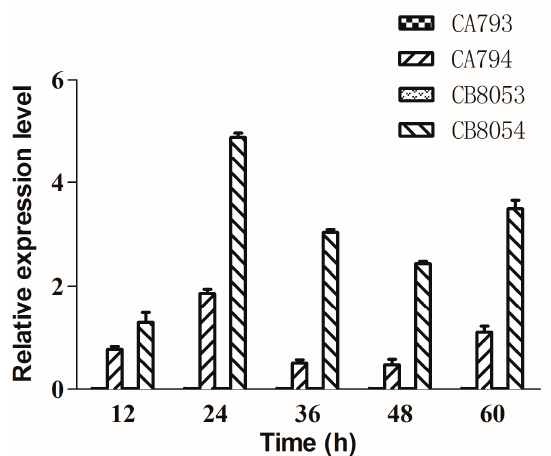
Figure 1. The expression of StSUT1 analyzed by quantitative real time polymerase chain reaction. Cells were collected at 12, 24, 36, 48, and 60 h. Three independent biological replicates were performed for each gene. The data represent the means of three separate experiments ± standard deviation. The control strains CA793 and CB8053 did not express StSUT1 .